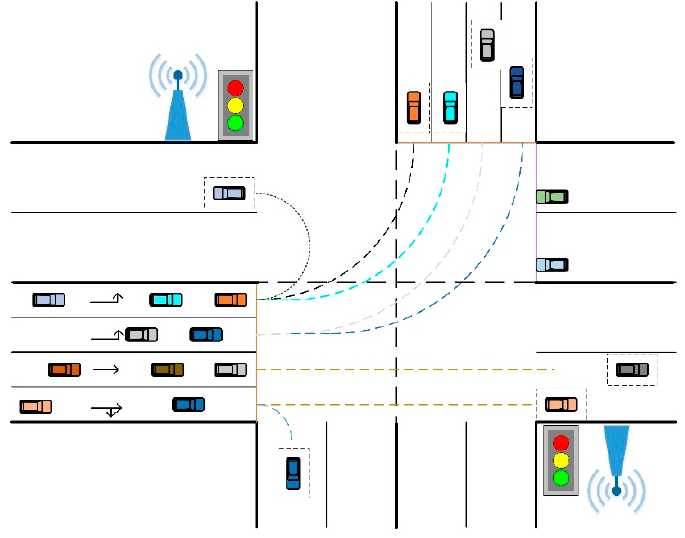
Figure 1. A typical multi ‐ lane intersection scenario.